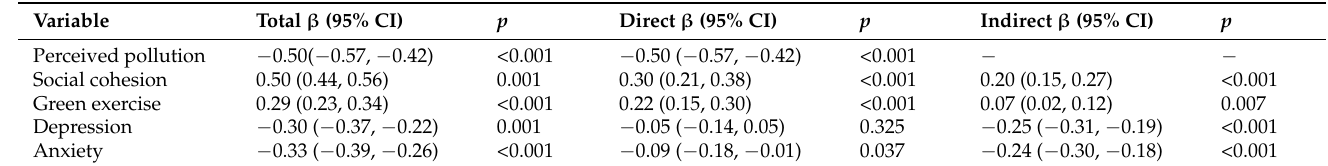
Table 3. Standardized total, direct, and indirect effects of perceived residential green space on the core